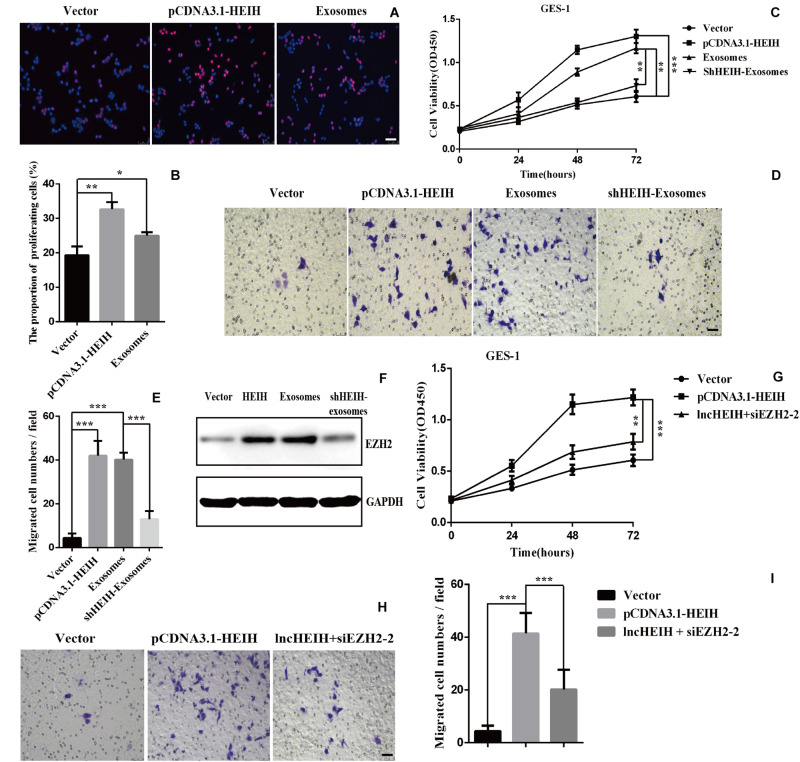
Exosome-delivered lncHEIH promotes the proliferation and metastasis of normal gastric cells by the lncHEIH-EZH2 axis. (A) Representative images showing the EdU+ proliferating GES-1 normal gastric cells transfected with lncHEIH or added exosomes to the medium for 48 h. The red color indicates EdU+ nuclei. Scale bars = 50 μm. (B) Graphs showing the proportion of EdU+ cells in different groups detected by flow cytometry. (C) CCK-8 analysis was used to determine the viability of GES-1 cells transfected with lncHEIH or added exosomes to the medium. (D,E) Transwell assays were used to determine the migration ability of GES-1 cells transfected with lncHEIH or added exosomes to the medium (scale bars = 50 μm). (F) The expression levels of EZH2 in GES-1 transfected with lncHEIH or added exosomes to the medium for 48 h. (G–I) CCK-8 and Transwell assays were used to determine the proliferation and migration of lncHEIH-overexpressing GES-1 cells transfected with siEZH2-2 (scale bars = 50 μm). *P < 0.05, **P < 0.01, ***P < 0.001.